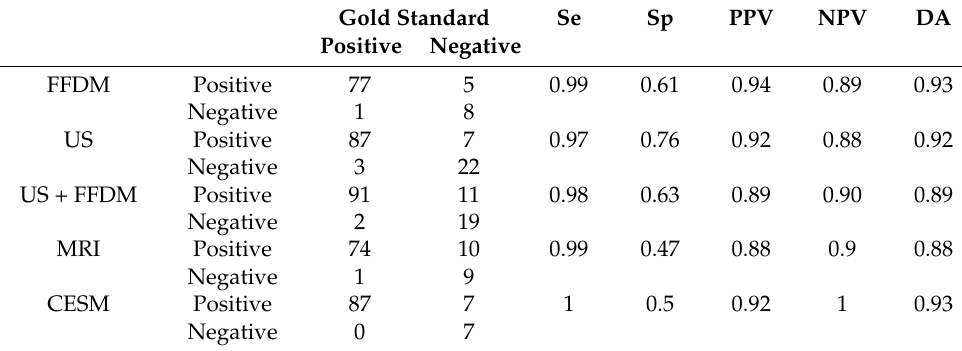
Table 6. Results for diagnostic accuracy (DA), sensitivity (SV), specificity (Sp), positive predictive value (PPV) and negative predictive value (VPN) for each modality and the gold standard.